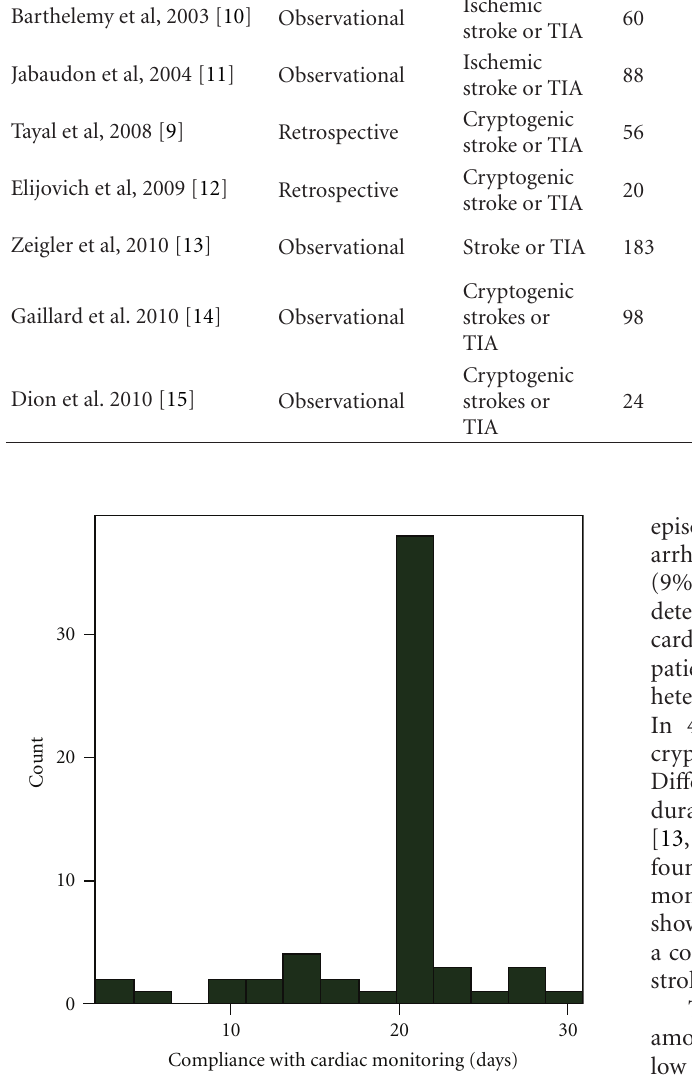
Figure 2: Compliance in days by patients with non-invasive cardiac